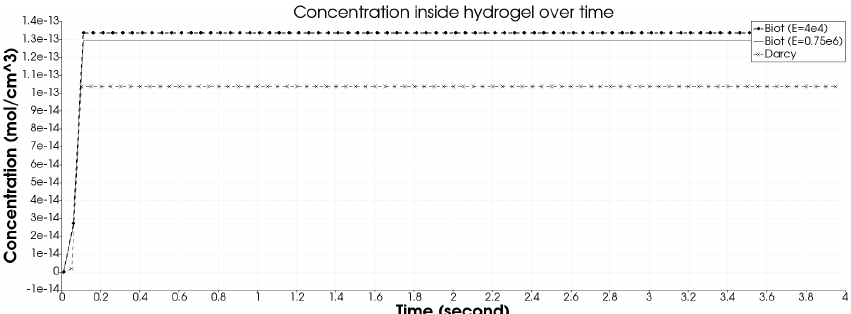
Figure 20. The curves show oxygen concentration over time for three different hydrogels with three different elasticity moduli: alginate hydrogel with Youngs modulus E = 4 × 10 4 Pascals, alginate with E = 0.75 × 10 6 Pa, and a very stiff scaffold made of Polycaprolactone (PCL) with E = 1.3 × 10 8 Pa. We see a significant increase in oxygen concentration for the most elastic alginate hydrogels with E = 4 × 10 4 Pa and E = 0.75 × 10 6 Pa over the stiff PLC with E = 1.3 × 10 8